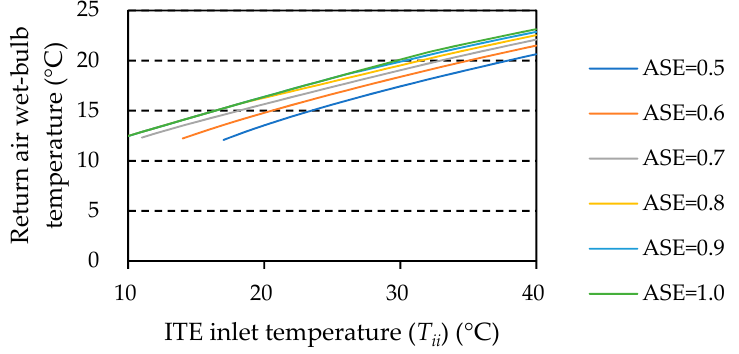
Figure 19. Return-air wet-bulb temperature of CRAC versus ITE inlet temperature ( T ii ).